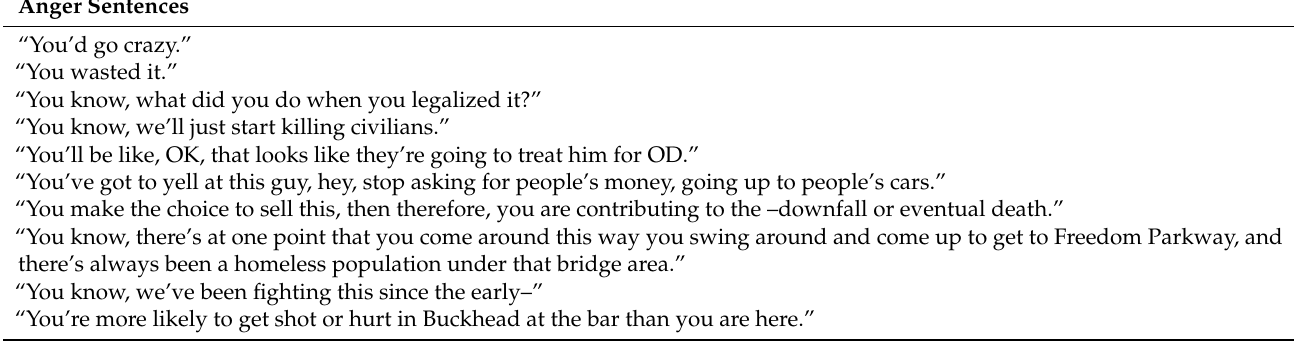
Table 1. Sentences scored as each of the 8